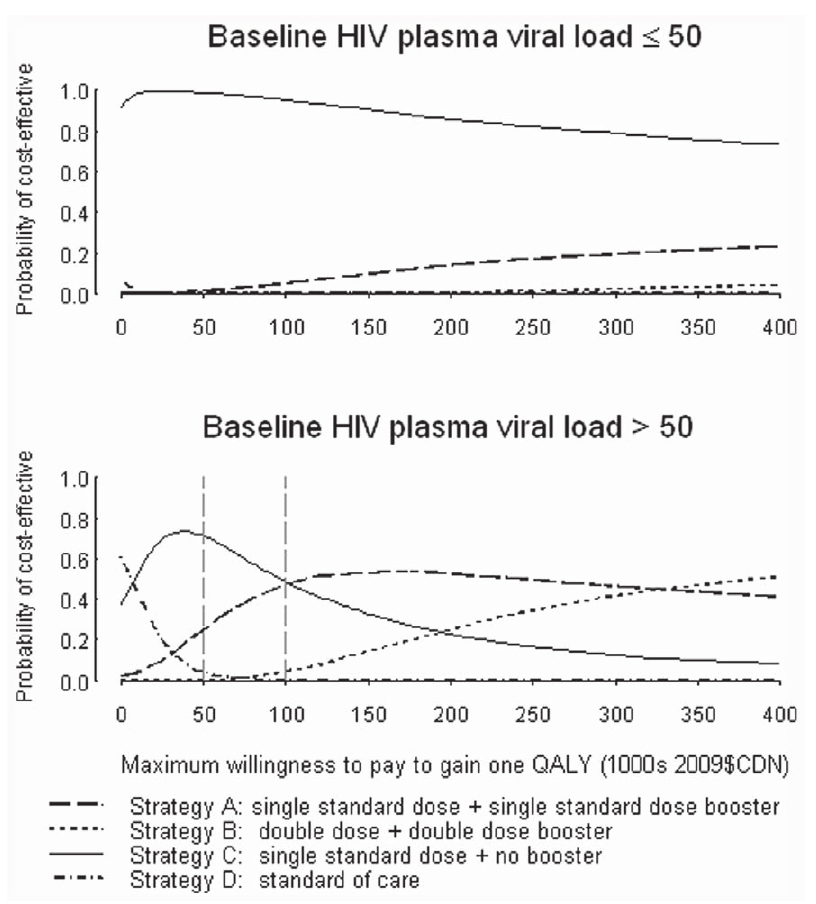
Figure 4. Cost-effectiveness acceptability curves.